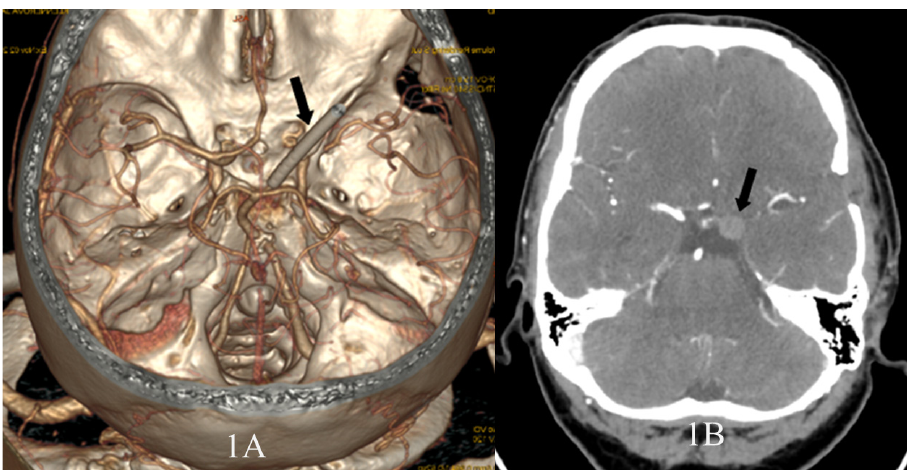
Fig. 1A. The volume CT angiography reconstruction shows occlusion of the communicating seg- ment of the left ICA, M1 and A1.There is an Ommaya reservoir (arrow), which is in vicinity of the occluded artery . B. The CT angiogram reveales fusiform thrombosed aneurysm of the ICA (arrow).